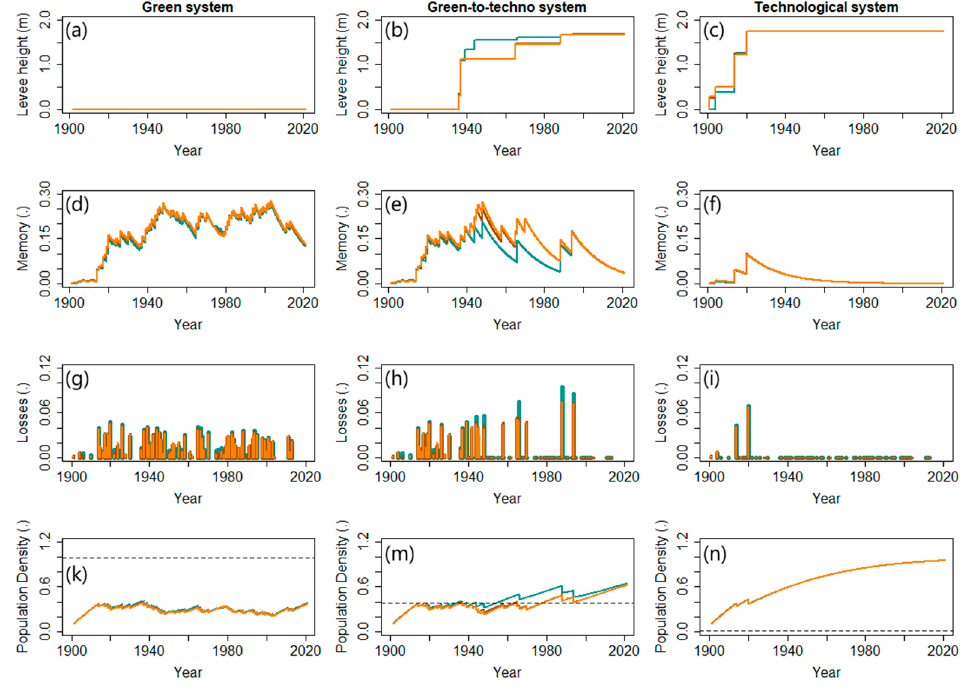
Figure 7. Levee height ( H ), collective memory ( M ), flood losses ( FD ), and population density ( D ) dynamics of green ( a , d , g , k ), green-to-techno ( b , e , h , m ), and technological ( c , f , i , n ) systems for values of memory decay rate µ equal to 0.10 year − 1 (light green), 0.15 year − 1 (brown), and 0.20 year − 1 (orange). Dashed lines indicate the values of the δ D parameter.